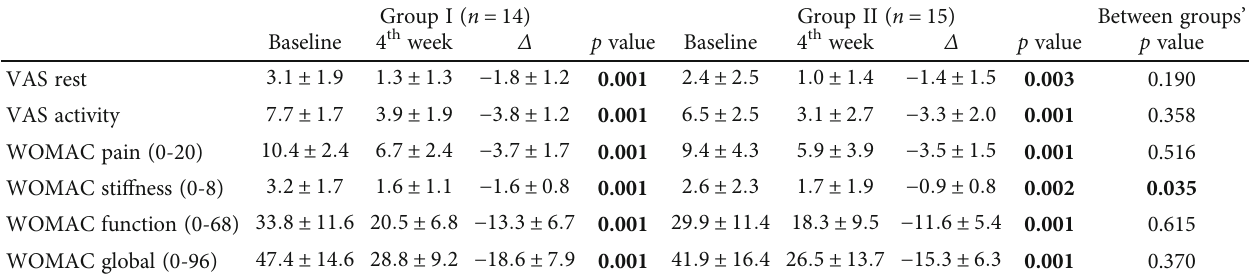
Table 3: Comparison of the VAS and WOMAC scores after the